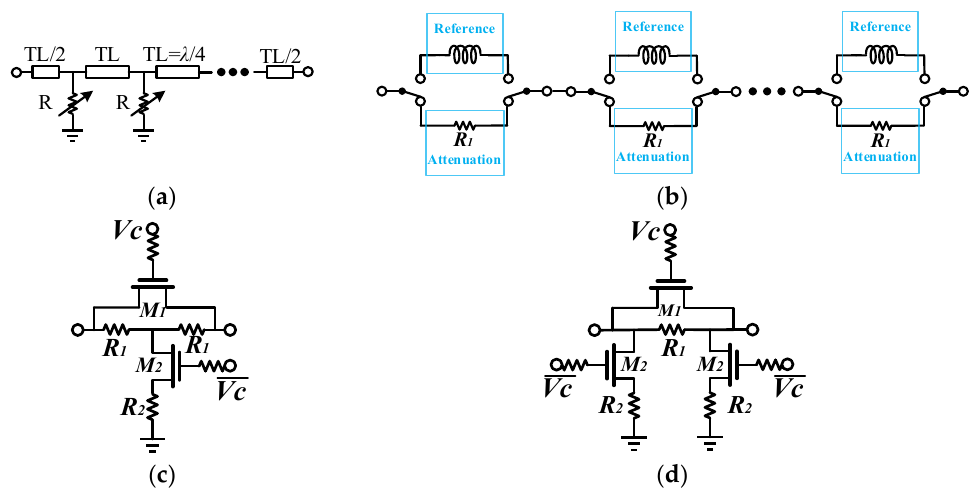
Figure 1. Topology of digital step attenuation cells. ( a ) Distributed step attenuator. ( b ) Switched-path attenuator. ( c ) T-type attenuation cell. ( d ) π -type attenuation